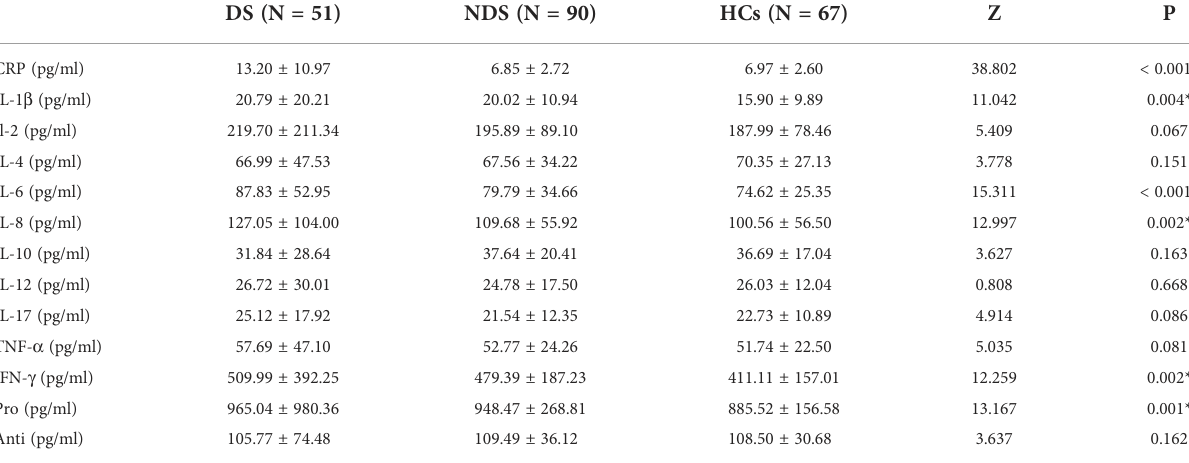
TABLE 2 Plasma proteins among control subjects, and de fi cit and nonde fi cit schizophrenia patients. DS (N = 51) NDS (N = 90) HCs (N = 67) Z